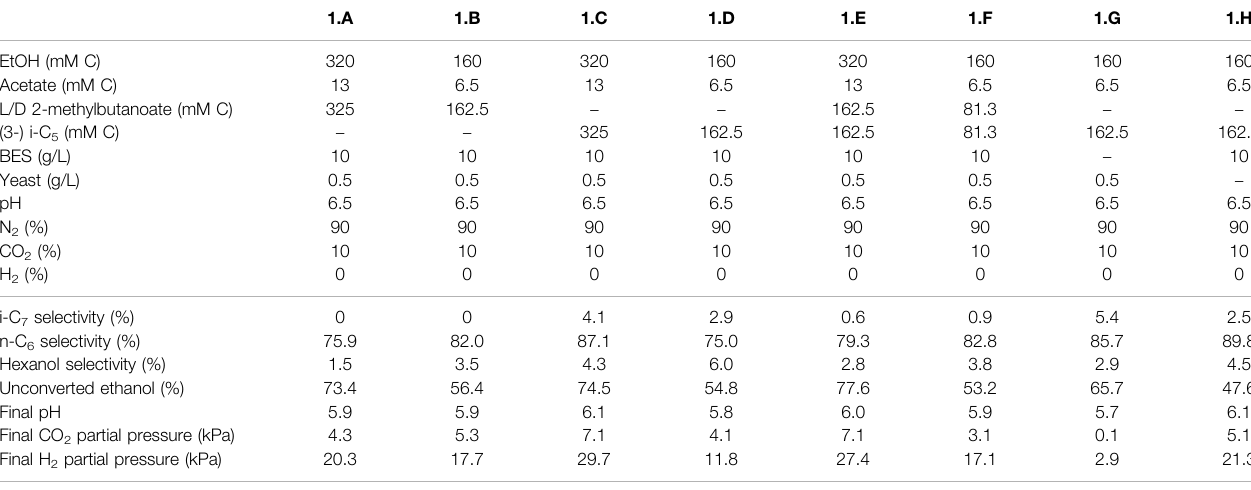
TABLE 2 | Overview of the different starting parameters (t (cid:2) 0) for the fi rst batch series, as well as fi nal values (t (cid:2) end) for product selectivites (% of total formed compounds based on carbon atoms) of i-C 7 , n-C 6 and hexanol, the percentages of unconverted ethanol at the end of the batch, pH and partial pressures of CO 2 and H 2 .